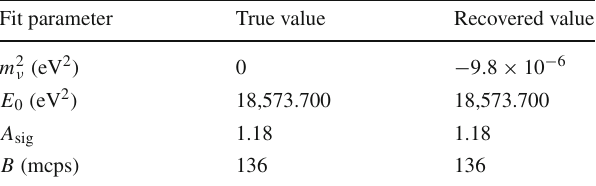
Table 2 Parameter recovery of the Asimov cross-fit. Our neural net- work recovers all true parameters with the bias in m 2 ν being less